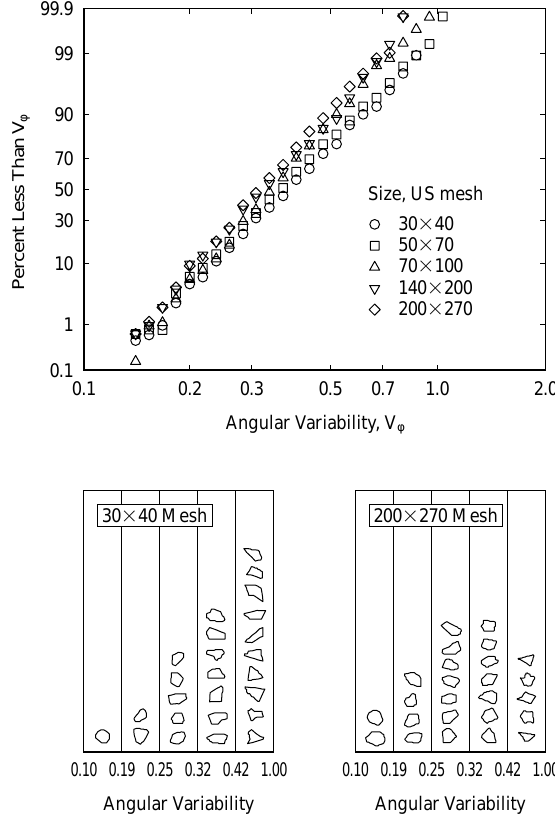
Graphical and visual representations of the number distri- butions of angular variability for coal particles produced in a jaw crusher (feed size 9.5 (cid:7) 12.7 mm; gap setting